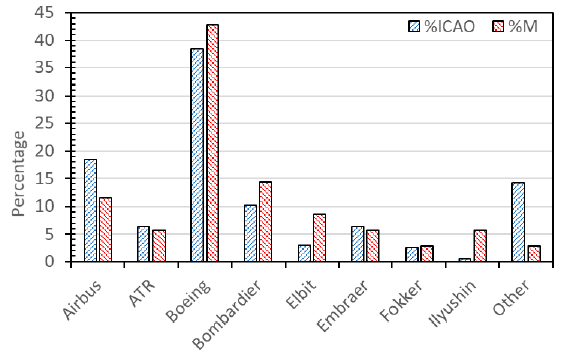
Figure 5. Distribution of aircraft manufacturer for accidents with maintenance contributions.